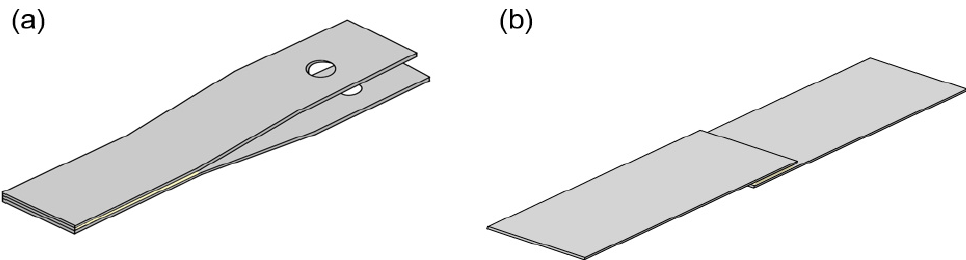
Figure 1. Impact wedge-peel (IWP) test specimen by Ford specimen design ( a ) and single lap joint (lap shear) test specimen ( b ).